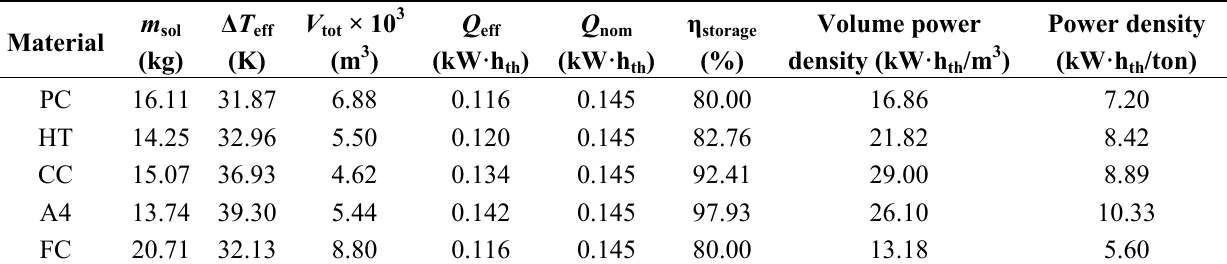
for selected nom